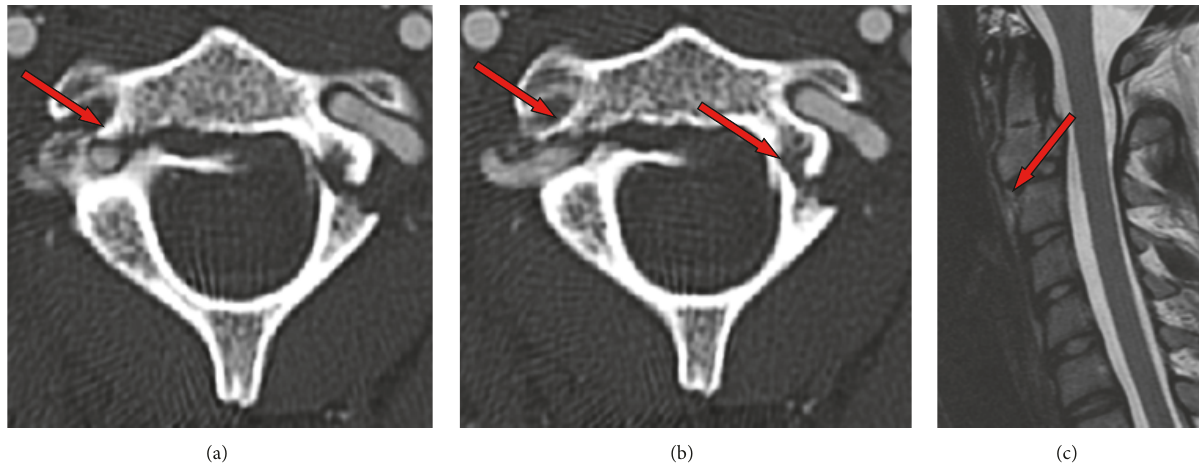
Figure 1: ((a) and (b)) Primary CT with contrasted dislocation of the artery in the fracture gap; (c) sagittal MRI arrows point to a small hematoma under the anterior longitudinal